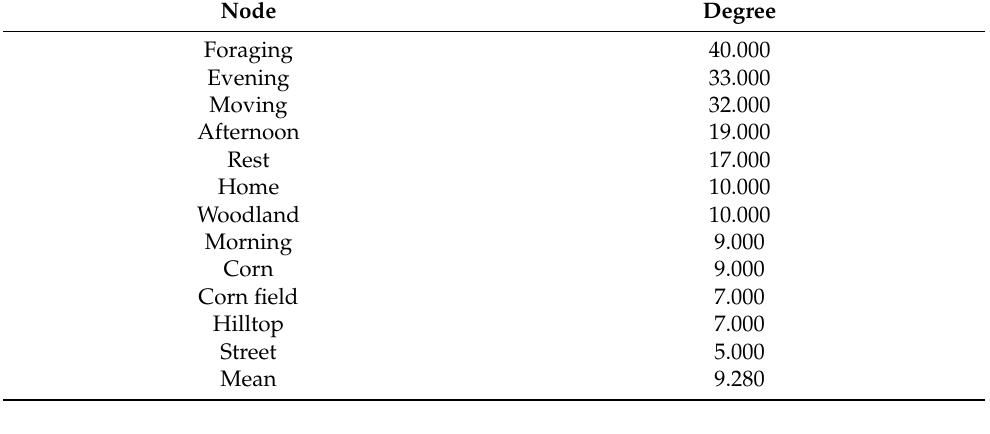
Table 7. Degree centrality of keywords.